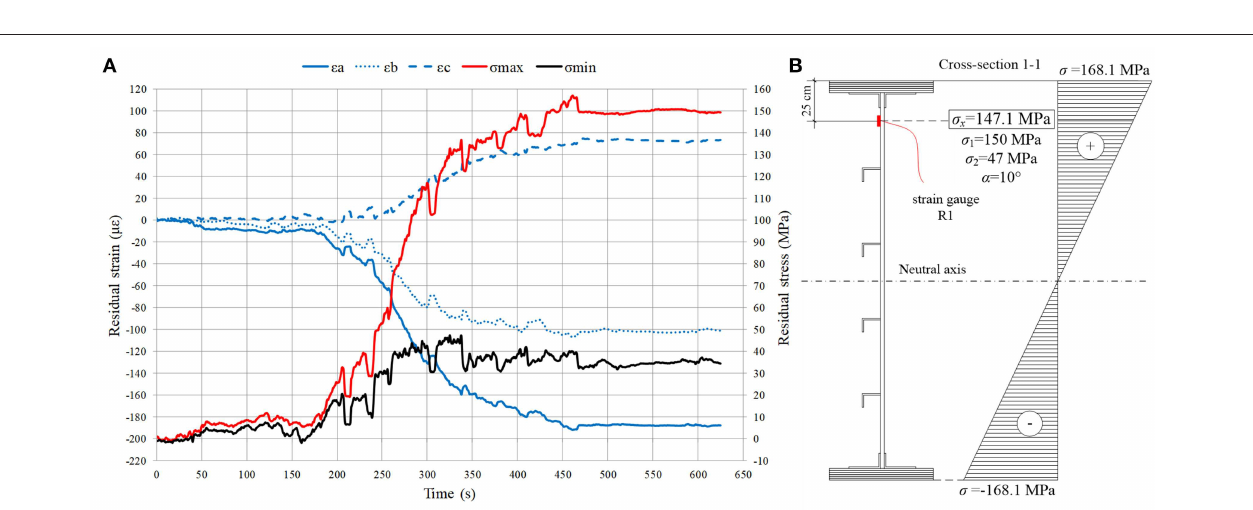
Frontiers in Built Environment |